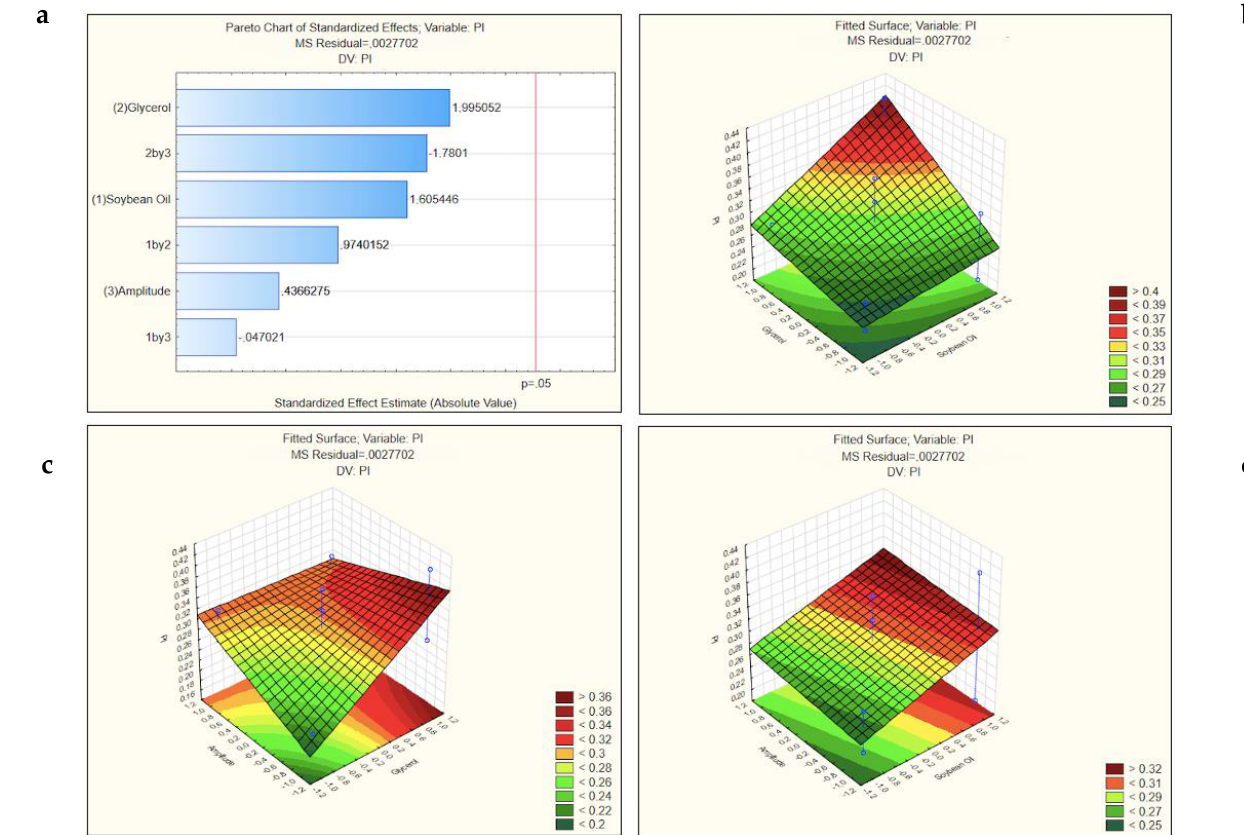
Figure 3. Pareto chart ( a ) and surface response graphs of the influence of the concentration of the glycerol and soybean oil ( b ), of soybean oil and amplitude ( c ) and of glycerol and amplitude ( d ) on the polydispersity index (PI).